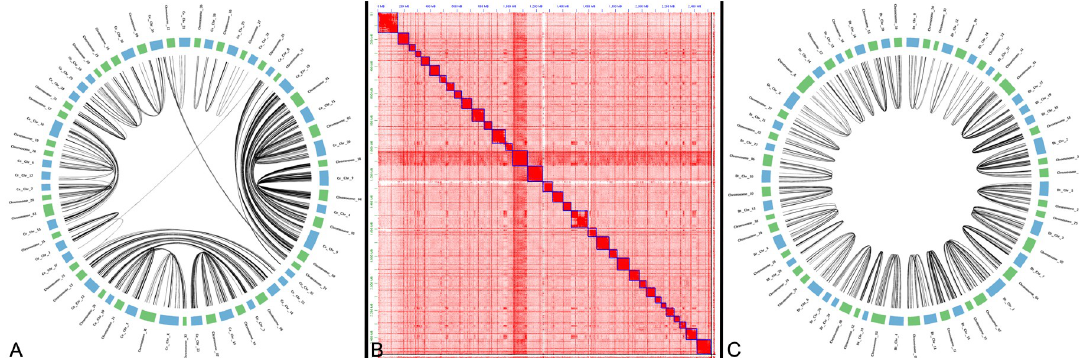
Fig 1. Synteny and Hi-C plot of elk chromosomes. A. Gene-based synteny between C . elaphus hippelaphus and C . canadensis . B. Hi-C plot of elk chromosomes in JuiceBox. C. Gene-based synteny between B . taurus and C . canadensis .